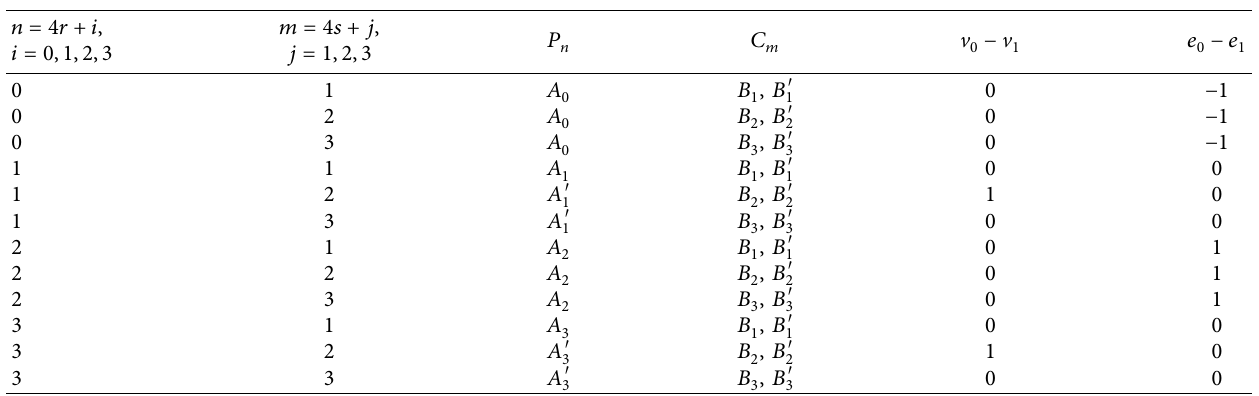
Figure 17: Logical labeling of P Table 4: Combinations of labeling.